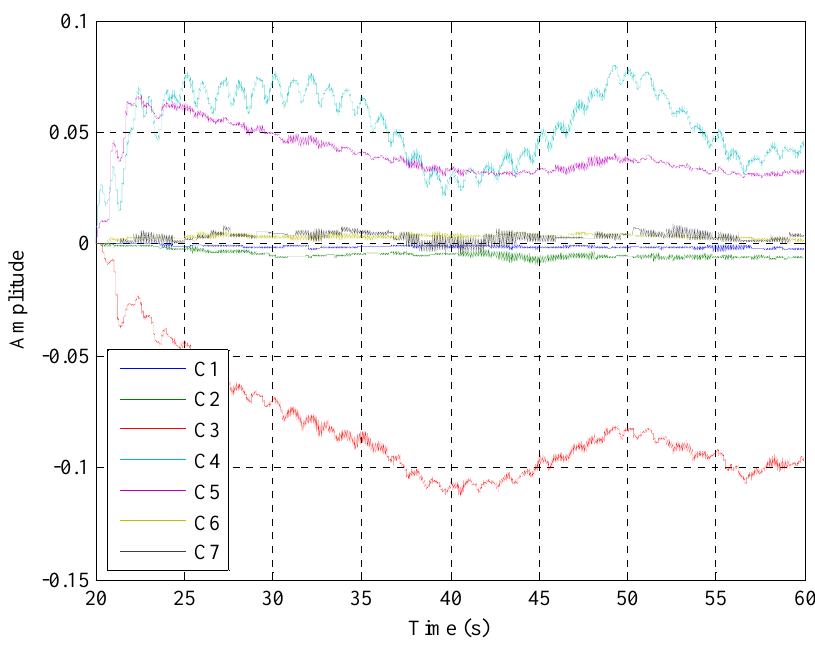
Figure 15. Fuzzy rule bank used in AFMSC vibration control system.